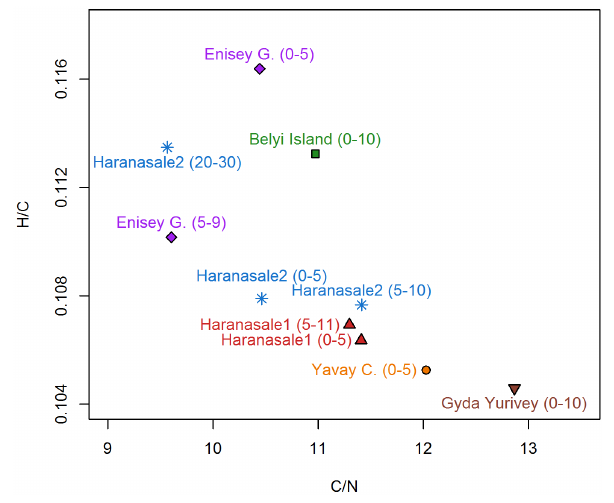
Figure 3. H / C vs. C / N scatter plot. Numbers in parentheses indi- cate the sampled soil depth in centimetres.